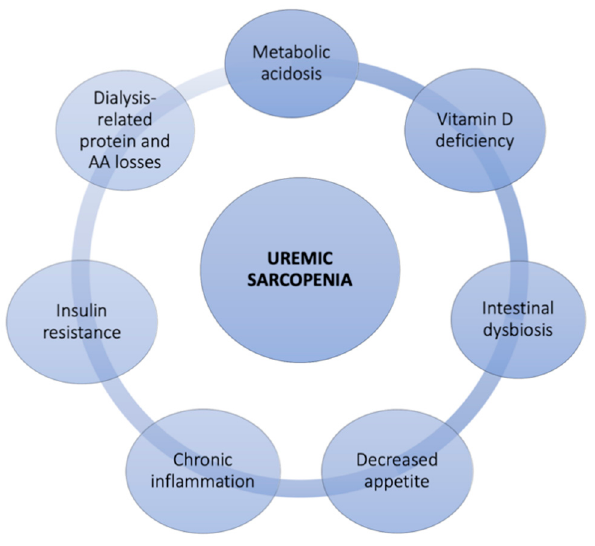
Figure 1. Possible causes of uremic sarcopenia. AA , amino acids .